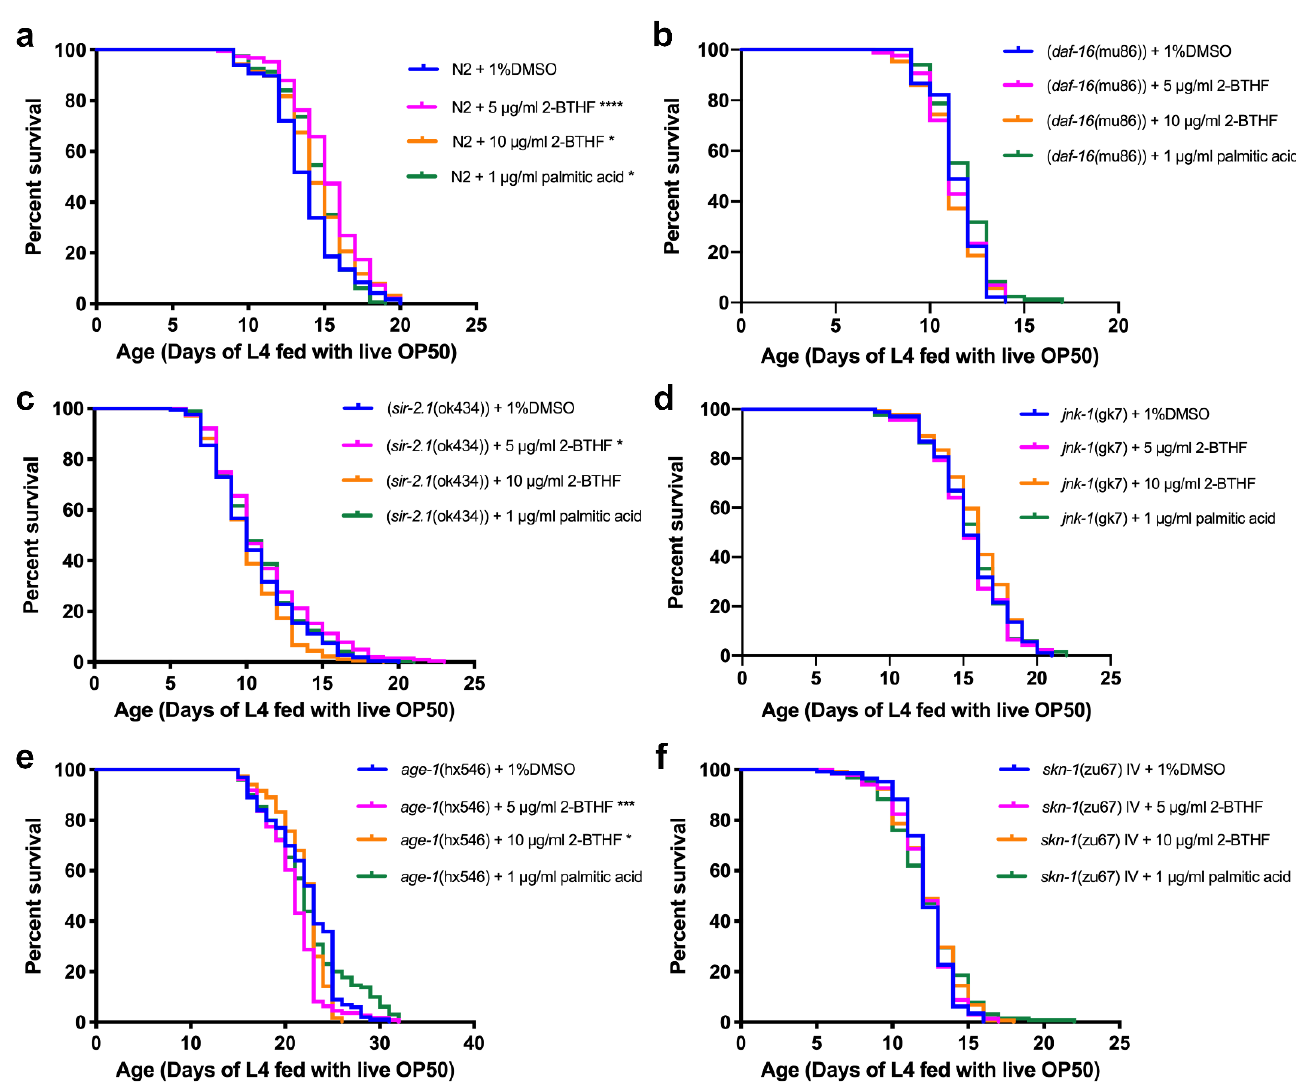
Figure 4. Effects of purified H. scabra compounds on the lifespans of wild type and mutant worms. The survival curves of N2 ( a ), CF1038 ( daf-16 (mu86)) ( b ), VC199 ( sir-2.1 (ok434)) ( c ), VC8 ( jnk-1 (gk7)) ( d ), TJ1052 ( age-1 (hx546)) ( e ), and EU1 ( skn-1 (zu67) IV) ( f ) treated with 1% DMSO, 5 μ g/mL 2-BTHF, 10 μ g/mL 2-BTHF, and 1 μ g/mL palmitic acid were shown. The survival curves were analyzed by using log-rank (Mantel-Cox) test for p value, * p < 0.05, *** p < 0.001, and **** p < 0.0001.